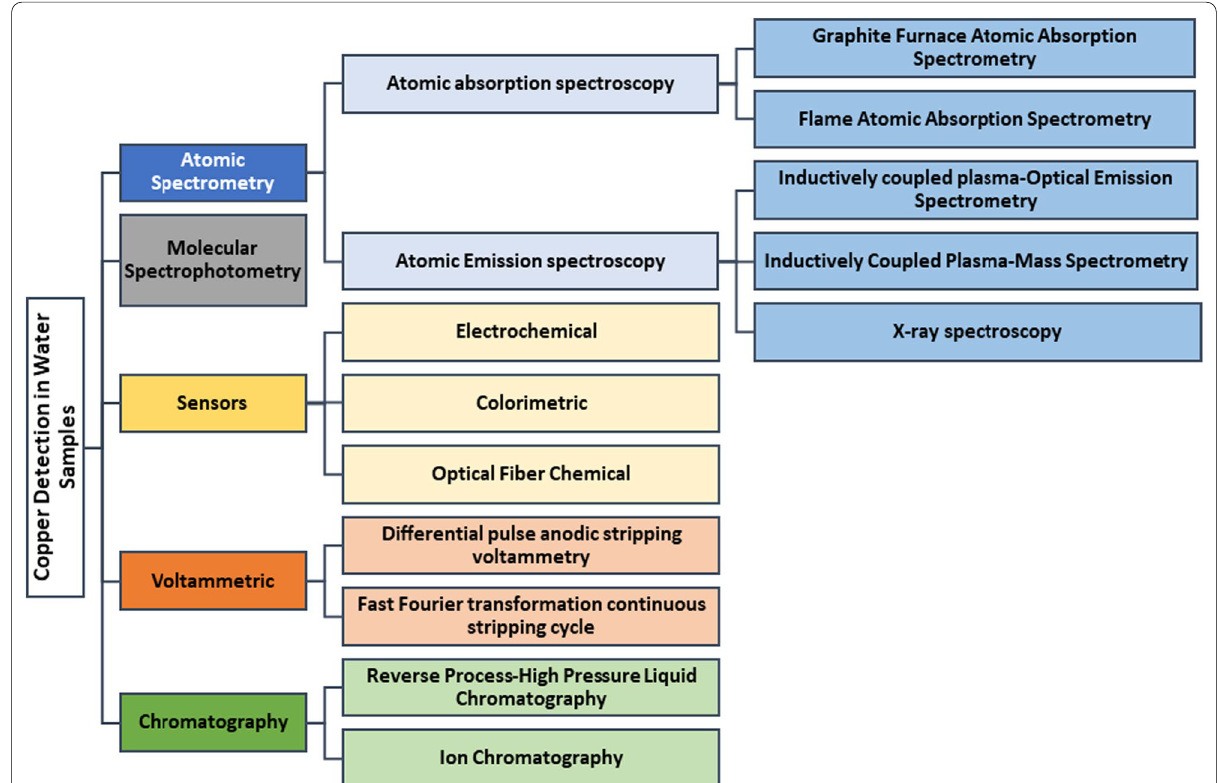
Fig. 1 Hierarchic graph of various Cu(II) detection methods in water